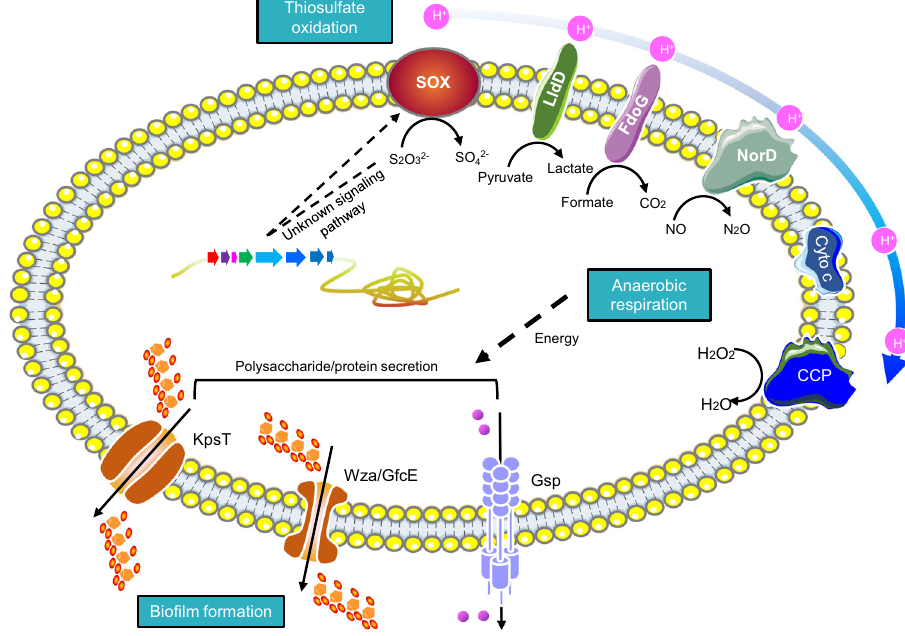
Fig. 6 | A schematic model to show the anaerobic respiration and bio fi lm formation driven by thiosulfate oxidation. The model is majorly based on the cell membrane proteomics results and the functions of proteins with increased abundance are